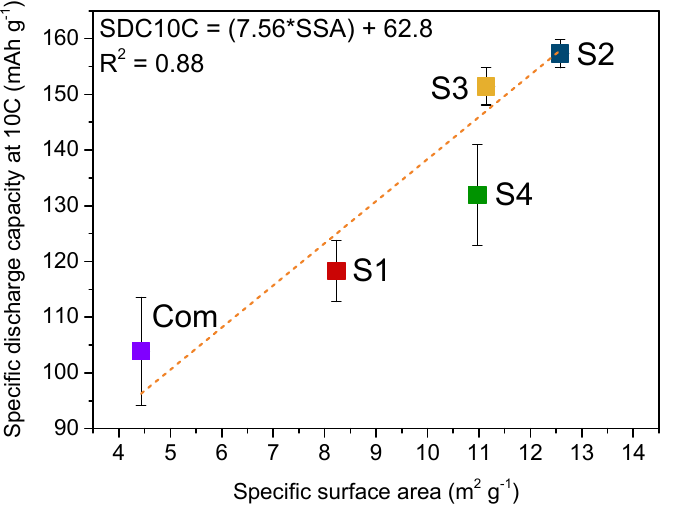
Figure 6. Specific discharge capacity at 10 C vs. specific surface area of sol–gel synthesized LTO (S1–S4) and commercial sample (Com).